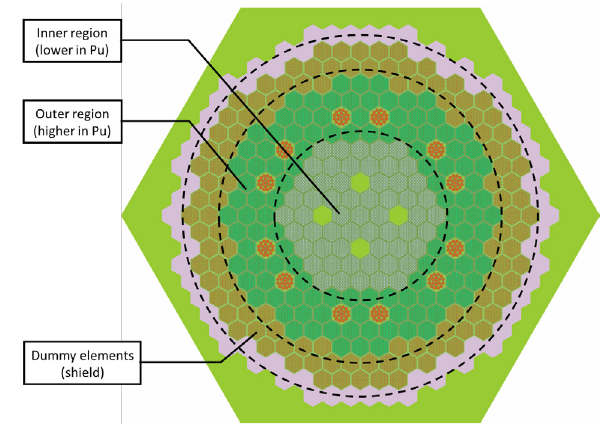
Figure 1. ALFRED core model.